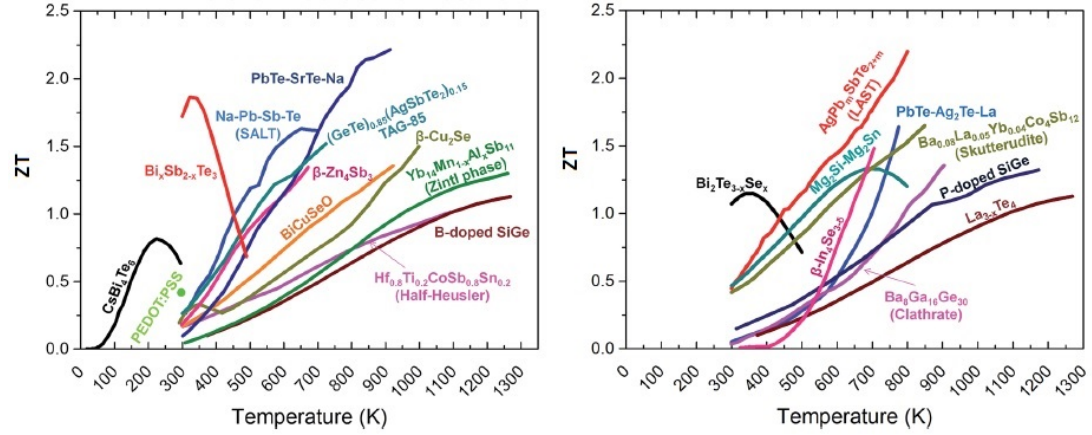
Figure 1. ZT values for some bulk thermoelectric materials as a function of temperature: (left) p-type TE materials and (right) n-type TE materials. Reproduced from [28] with permission from The Royal Society of Chemistry.